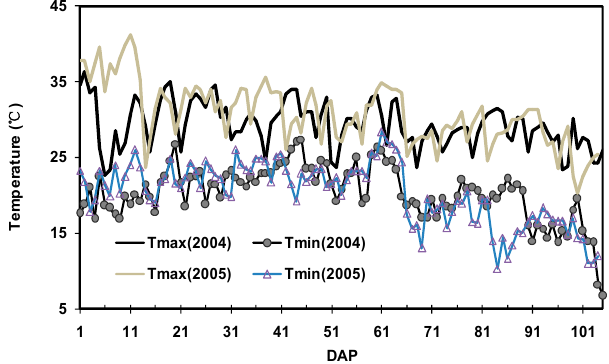
Figure 3. Maximum and minimum temperature during the summer maize season in 2004 and 2005. Tmax: maximum temperature; Tmin: minimum temperature; and DAP: days after planting.